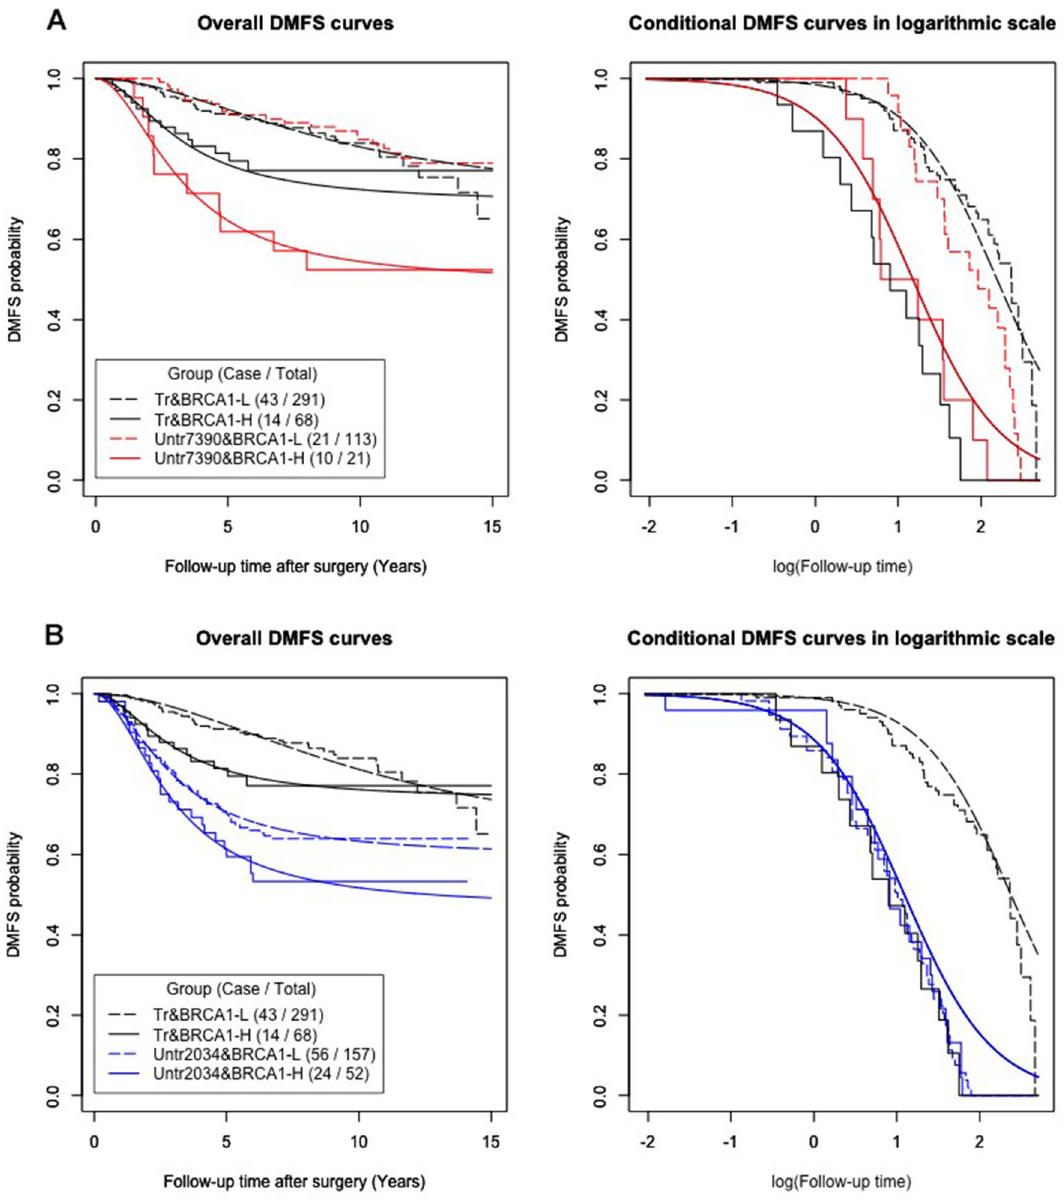
Figure 4. Logistic AFT mixture regression models for tamoxifen-treated and untreated patients. The chosen model was based on BRCA1 cutoff 8th decile. Survival curves for the tamoxifen-treated cohort, untreated GSE7390 cohort and untreated GSE2034 cohort are shown in black, red and blue, respectively. High- and low- BRCA1 expression subgroups are shown with solid and dashed lines, respectively. ( A ) Treated group and untreated GSE7390. In the overall DMFS plot, the two low- BRCA1 groups (red and black dashed lines) were fitted as the same group by the model. In the conditional DMFS plot, the two low- BRCA1 groups were fitted as the same group by the model, as were the two high- BRCA1 groups. ( B ) Treated group and untreated GSE2034. In the conditional DMFS plot in the right panel, both BRCA1 expression groups of GSE2034 were fitted to be the same as those of the high BRCA1-treated